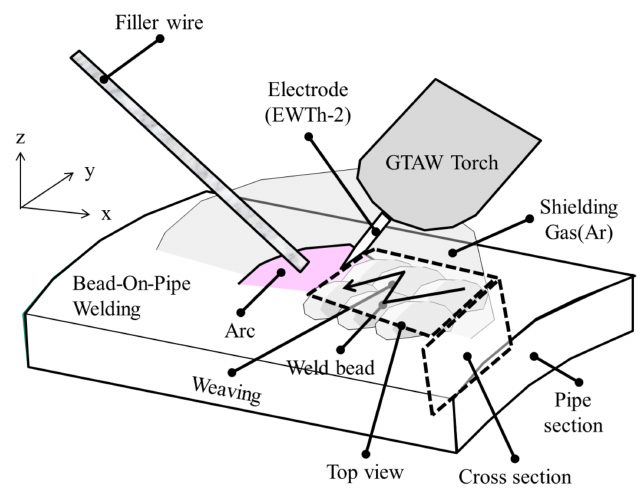
Figure 1. Schematic of bead-on-pipe